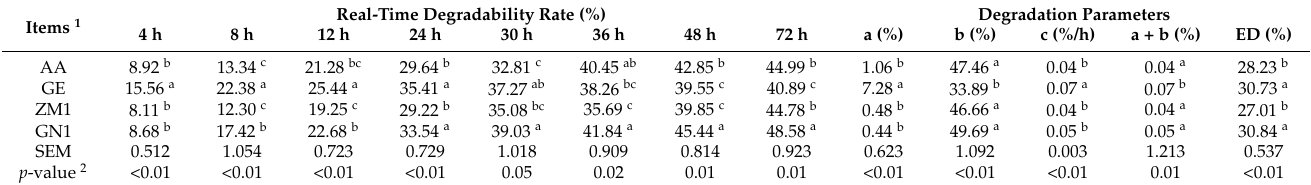
Table 7. Rumen degradable characteristics of ADF from various alfalfa hay cultivars %.